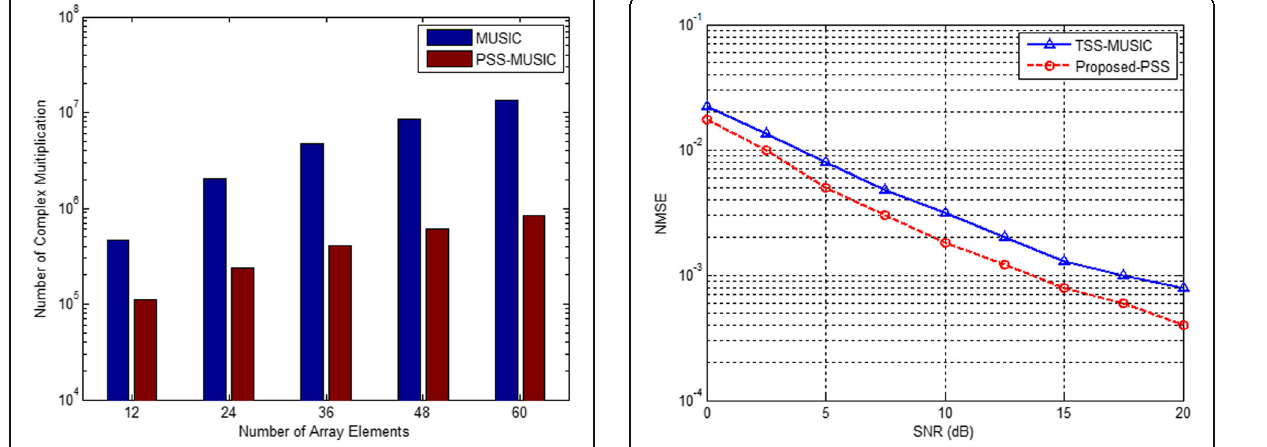
Fig. 11 The NMSE versus SNR. The picture shows that the proposed channel estimation performs better than the method based on TSS- MUSIC M = 7 and N =